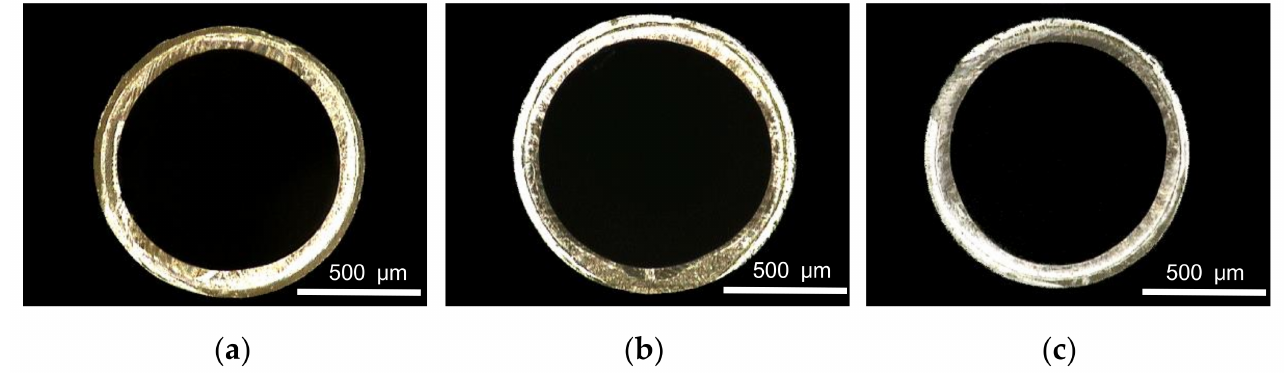
Figure 12. Cross section of micro tubes at different die temperatures: ( a ) Die temperature = 190 ◦ C; ( b ) Die temperature = 205 ◦ C; ( c ) Die temperature = 220 ◦ C.